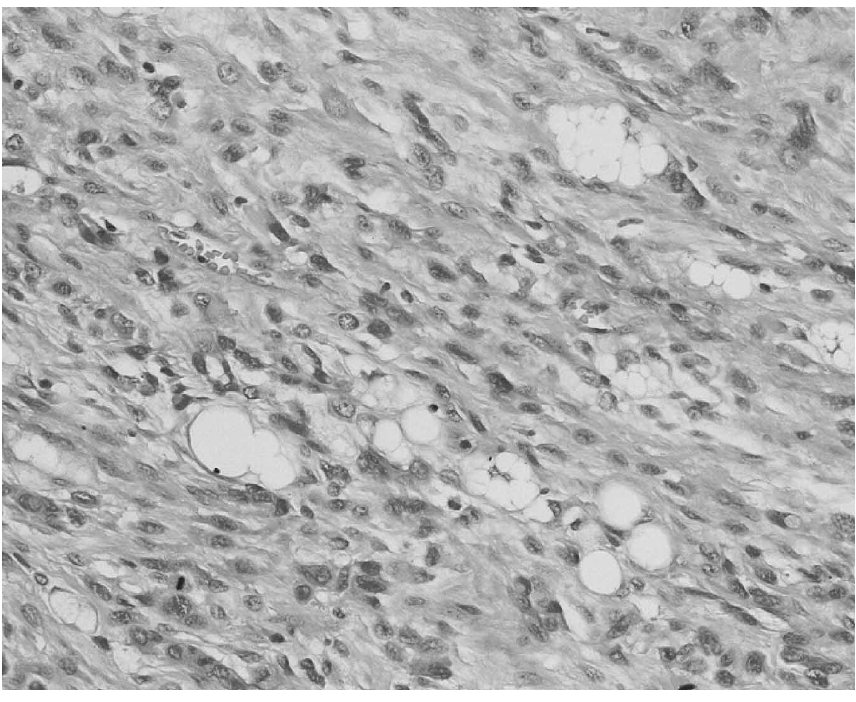
Fig. 2. Pleomorphic